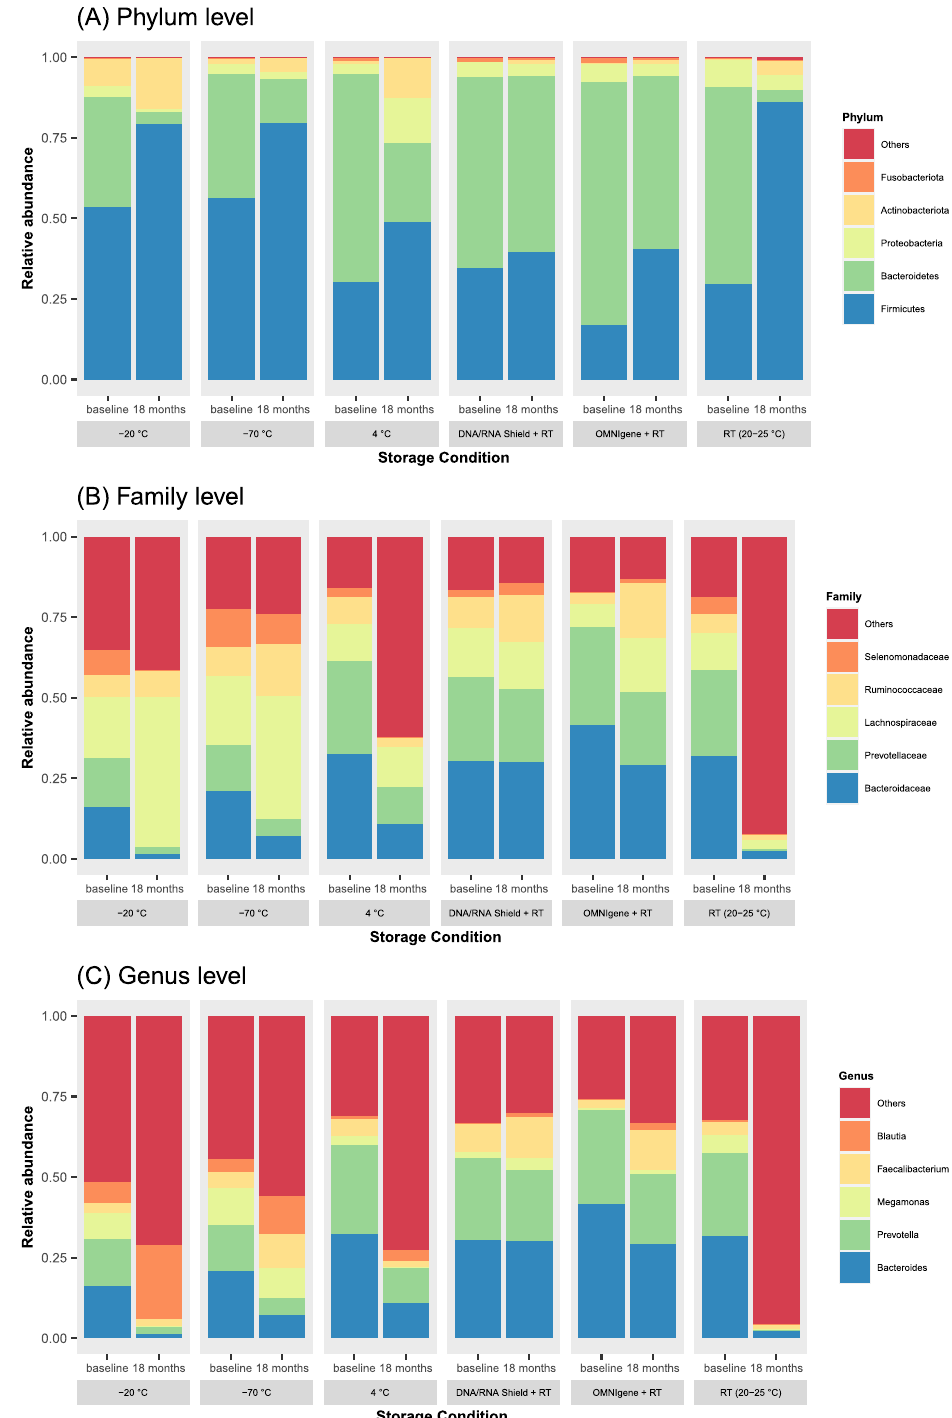
Figure 1. Comparison of the taxonomic composition at the ( A ) phylum, ( B ) family and ( C ) genus levels according to the tested storage conditions. DNA/RNA Shield DNA/RNA shield-fecal collection tube, OMNIgene OMNIgene-Gut, RT room temperature (20–25